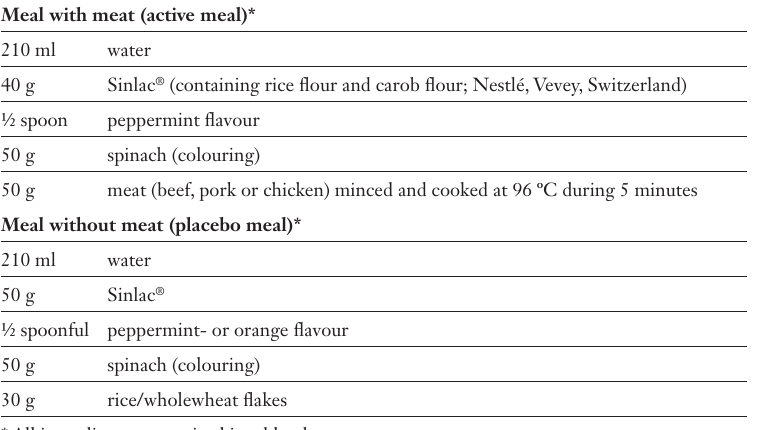
Recipe for DBPCFCs with meat.